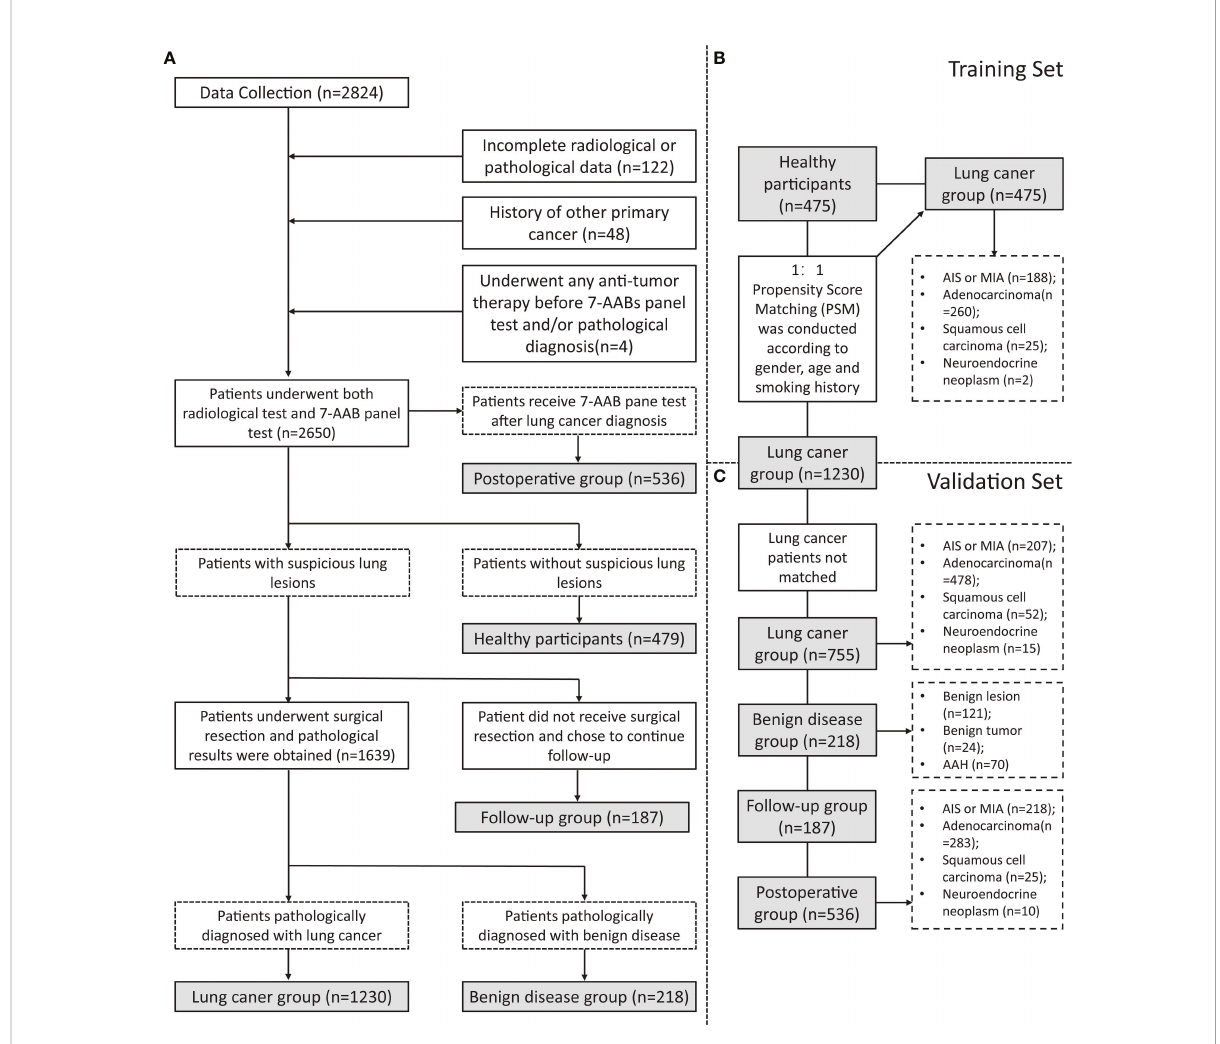
FIGURE 1 Flowchart of inclusion and grouping. (A) A fl owchart of the inclusion and exclusion of participants in this study; (B) A fl owchart of participants in training set matching by Propensity Score Matching (PSM); (C) A fl owchart of participants inclusion in validation